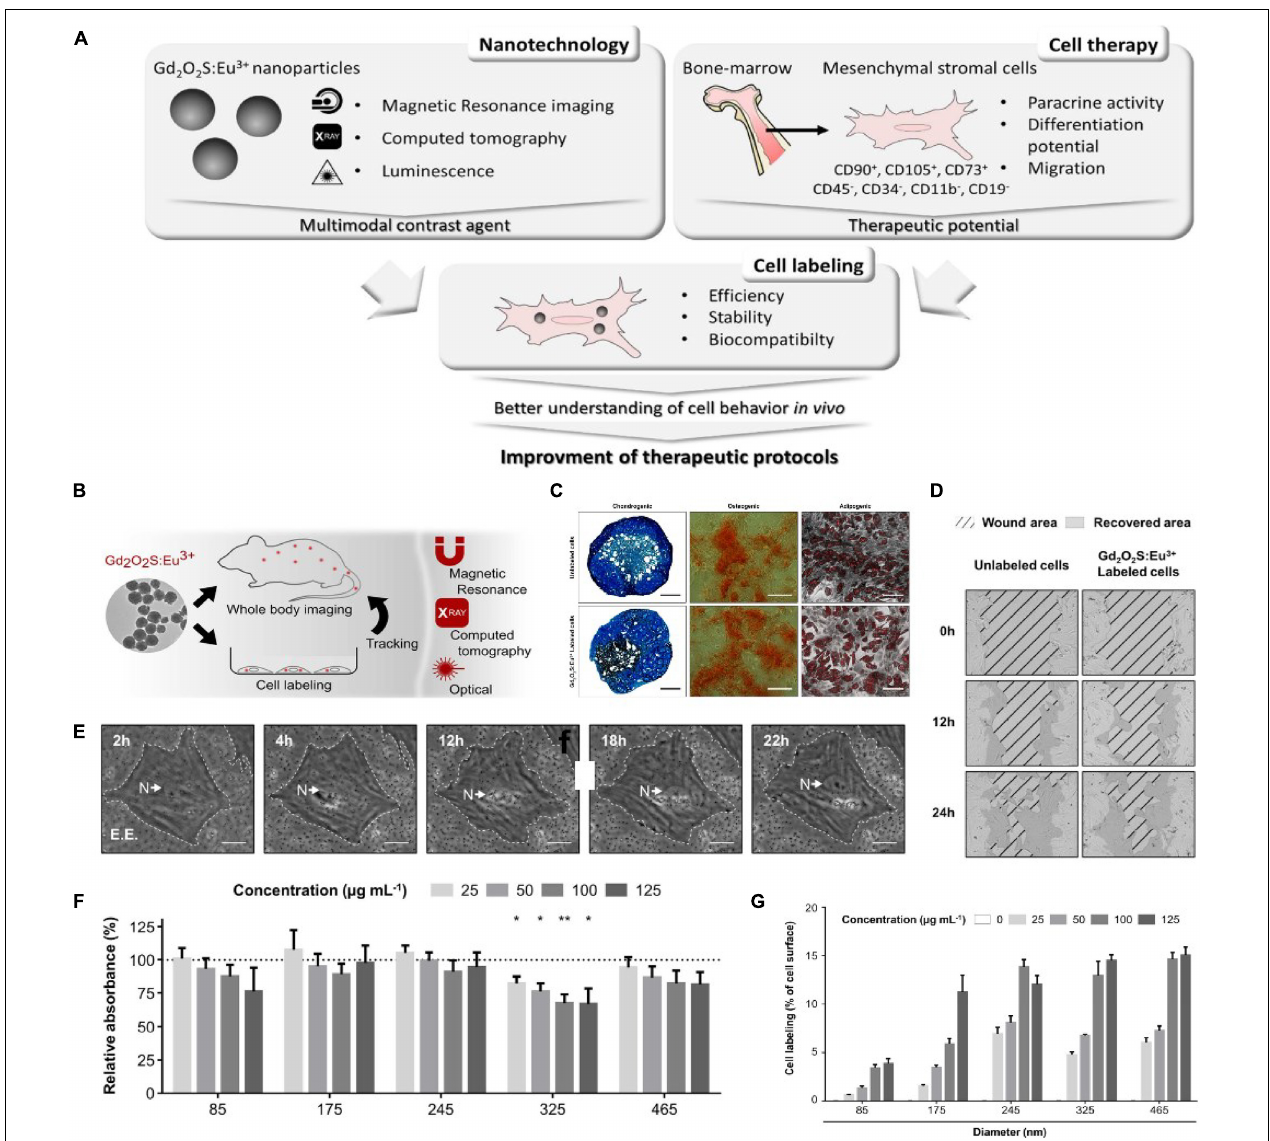
FIGURE 2 | (A) Schematic representation of nanoparticle potential in cell therapy and future impact. (B) Multimodality imaging for tracking mesenchymal stem cells (MSCs). (C) Differentiation of MSCs (scale bar 150 µ m). (D) Representative phase-contrast images of wound closing. (E) Time-lapse of labeling extracted from video microscopy acquisition. (F) Viability of MSCs after 24-h Gd 2 O 2 S:Eu 3 + labeling evaluated by MTT. (G) Quantification of MSC labeling with Gd 2 O 2 S:Eu 3 + expressed as the percentage of cell surface area occupied by NPs (adapted by Santelli et al.,